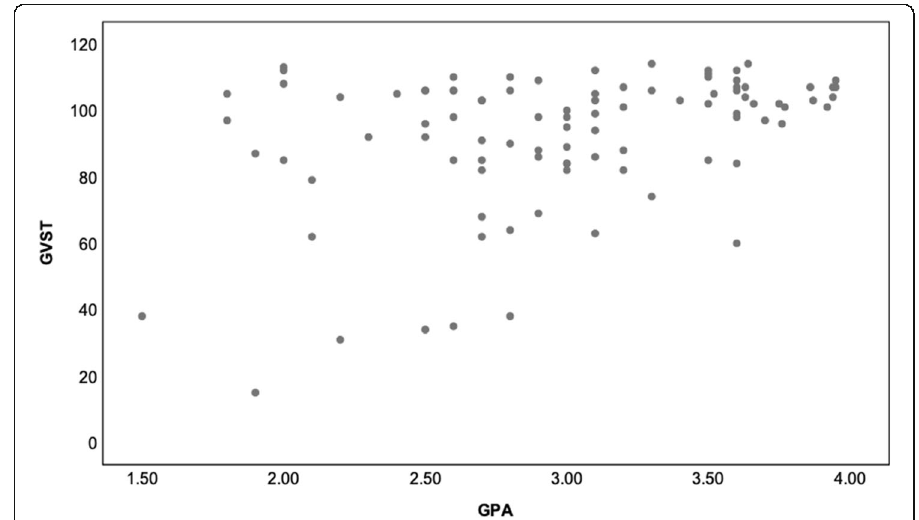
Fig. 3 comparison of GVST and GPA